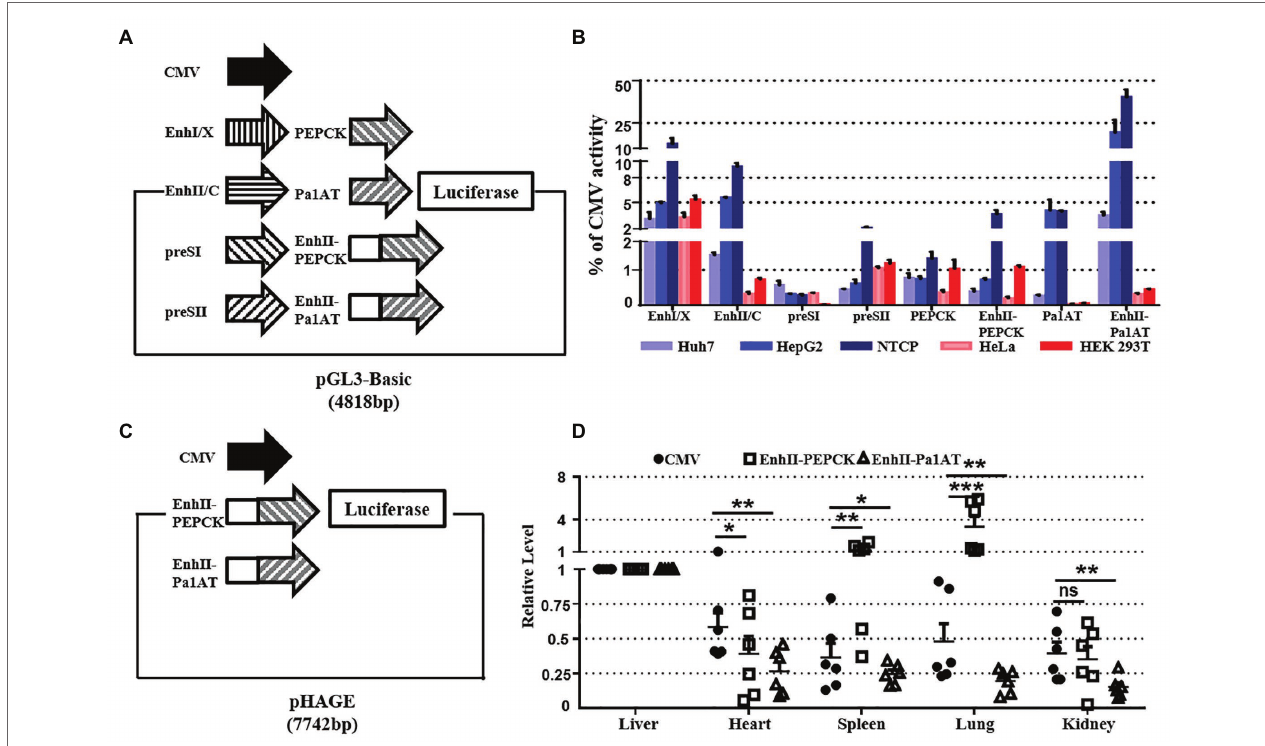
FIGURE 3 | Activity of liver-specific promoters in vitro and in vivo . (A) Schematic of the reporter plasmids for studying specificity in vitro . Nine promoters were inserted into the pGL3-Basic plasmid. (B) Promoter activity in hepatoma and non-hepatocellular carcinoma cell lines. Hepatic (Huh7, HepG2, and NTCP) and non- hepatic (HeLa and HEK293T) cell lines were transiently transfected with reporter plasmids. (C) Schematic of the reporter plasmids for studying the specificity in vivo . Three luciferase linked promoters inserted into pHAGE plasmid for packaging lentivirus. (D) The mice were divided into three groups, and we injected the lentivirus- packaged luciferase reporter system. At 7 days post-injection, organ samples were harvested and luciferase mRNA was measured using RT-qPCR. The pRL-TK plasmid was included to normalize the transfection efficiencies, and Dual-Luciferase assay results were calculated from three independent experiments. The data are presented as the mean ± SEM. * p < 0.05, ** p < 0.01, and *** p < 0.001, ns, no